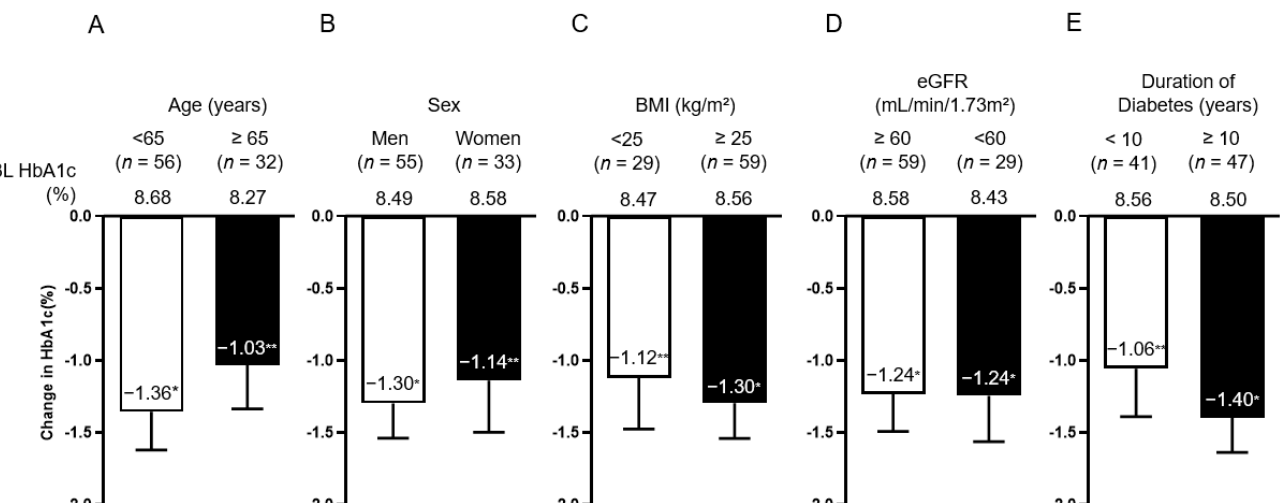
Figure 2. Change in HbA1c ( A , B ) and BW ( C ) from baseline overall at 6 months and the proportion of patients achieving HbA1c < 7% ( D ). Data in the figure are shown as mean with SEM. * p < 0.001 in the Wilcoxon signed-rank sum test ( B , C ) and McNemar’s test ( D ) (vs. BL). BL, baseline; HbA1c, glycated hemoglobin; BW, body weight; SEM, standard error of the mean.